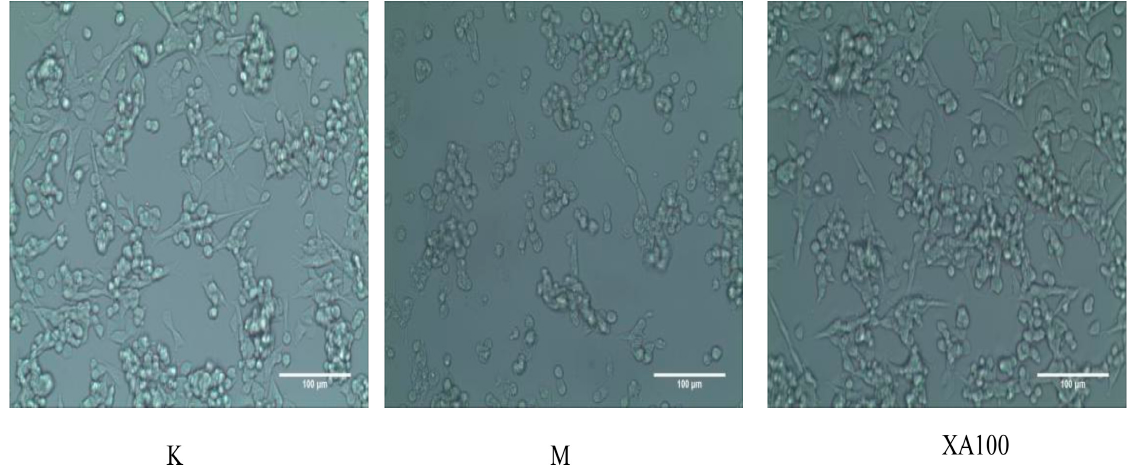
Figure 2. Morphological changes in MN9D cells as observed under an inverted microscope (×200). K: Control group; M: Model group; XA100: 100 μ M XA.